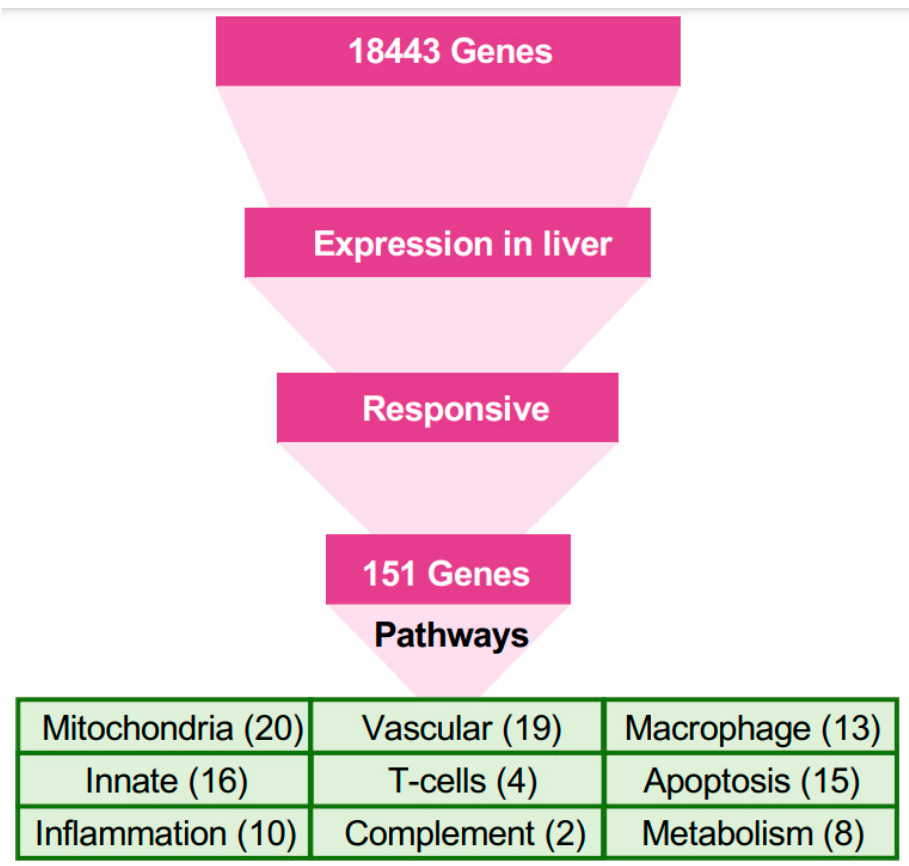
Figure 3. A pathway-based approach for understanding the response to filovirus infections. The approach used in this study was based on identification of pathways relevant to the bat’s resilience to filoviral infections, under the assumption that homologous genes perform similar functions in bats and humans. Since the liver is the locus of viral replication (viral transcripts are mostly found in the mRNA from livers), genes that were highly expressed in livers and responsive to the infection in bats were first identified. The genes were mapped to pathways, and other genes in the pathways were evaluated to identify the systemic response to filovirus infections in bats and to identify key differences from the responses in humans. Blood pressure, coagulation, and iron homeostasis pathways were altered most prominently. The analysis demonstrated changes in glycolysis, which is controlled by hypoxia, which shift the balance of macrophage activation from the M1 (proinflam- matory) to the M2 (anti-inflammatory) state. These changes create a pro-inflammatory state that modulates the response and allows the adaptive immune system to clear the infection early, and anti-inflammatory response late. The identified pathways demonstrated incomplete activation of the complement system, likely compromising the antibody response, but strong activation of T cell response, which is likely to play a major role in clearing the infection. The identified pathways are interconnected, leading to the coordinated changes shown in Figure 4 and connections delineated in Figure 5.